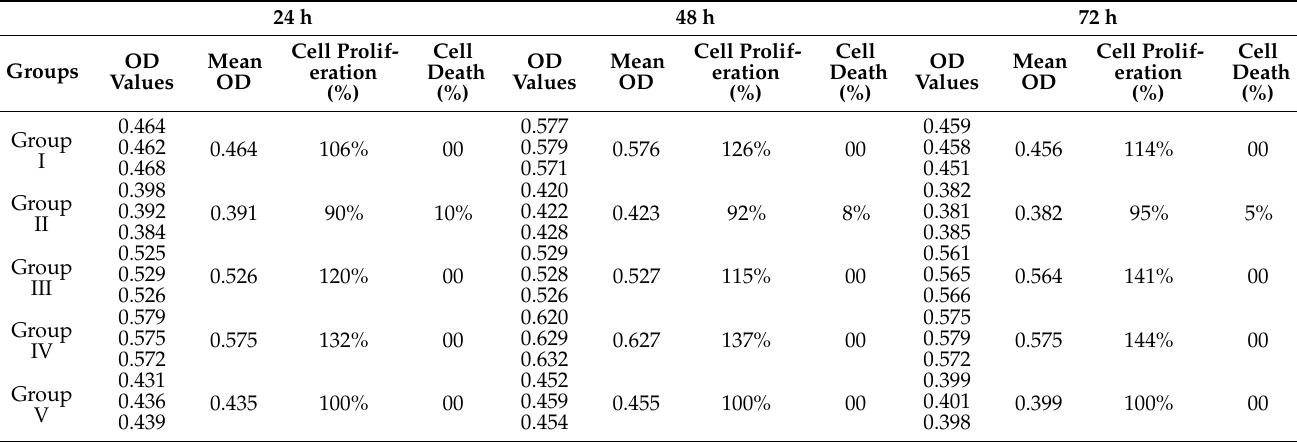
Table 1. MTT assay results (cell viability and cytotoxicity) for groups at 24, 48, and 72 h. 24 h 48 h 72 h